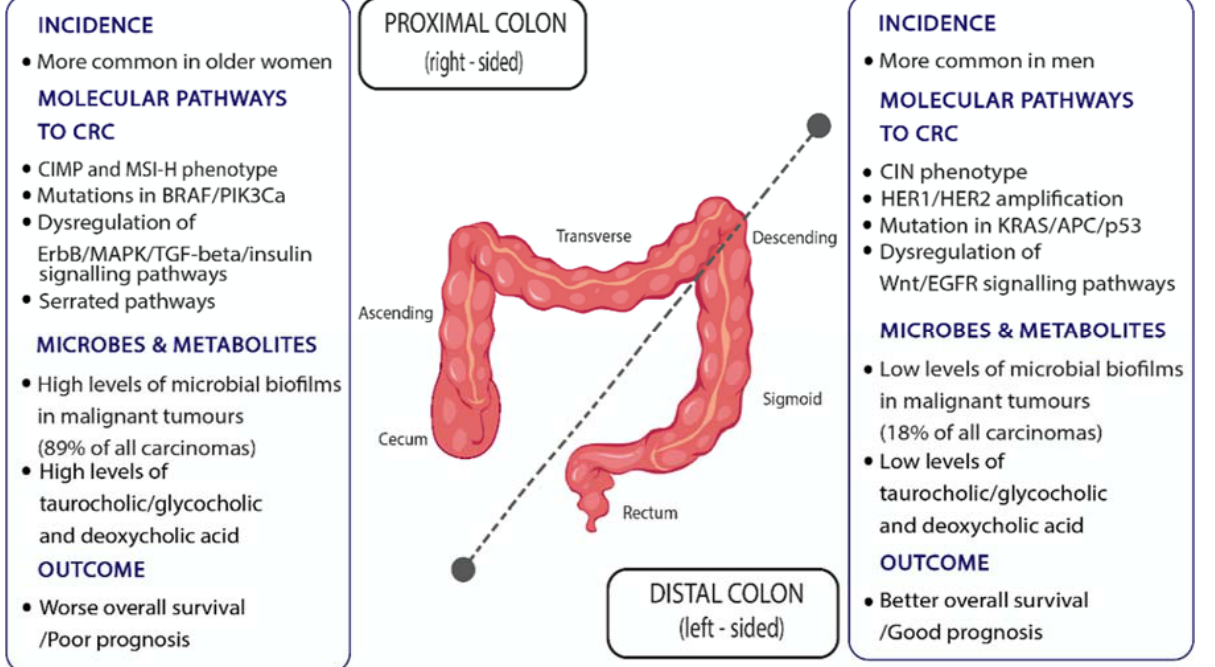
Figure 2. Proximal and distal colon regionalization in terms of CRC incidence, outcome, molecular pathways leading to CRC, and microbes and metabolites involved.